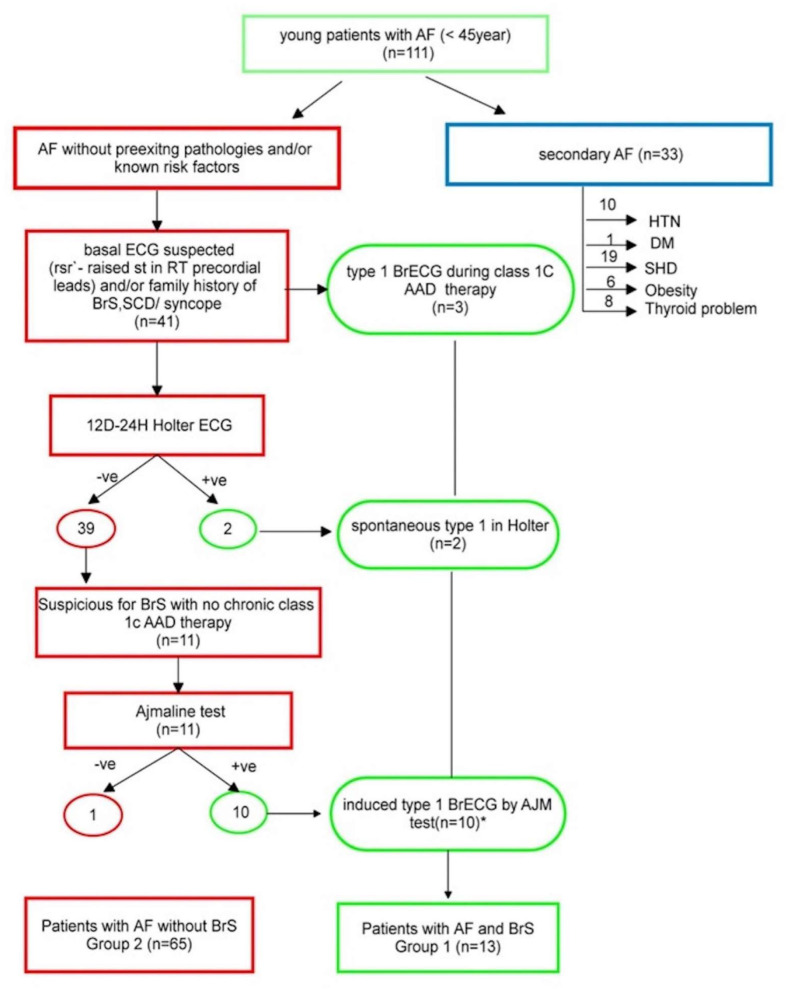
Study flowchart. *including the two patients who are +ve in Holter. AAD, antiarrhythmic drug; AF, atrial fibrillation; DM, diabetes mellitus; HTN, hypertension; SCD, sudden cardiac death; SHD, structural heart disease; +ve, positive; –ve, negative.